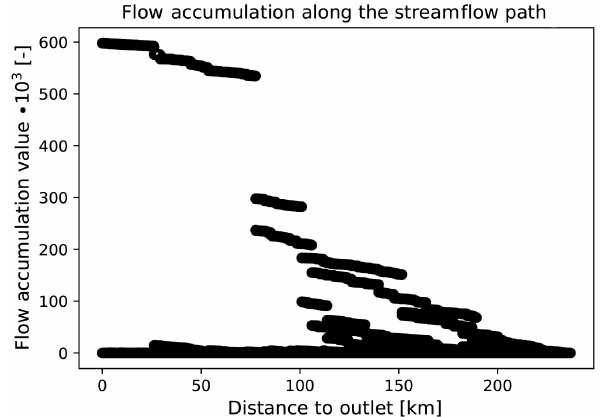
Figure A2. Distance-factor function of flow accumulation in the catchment of the